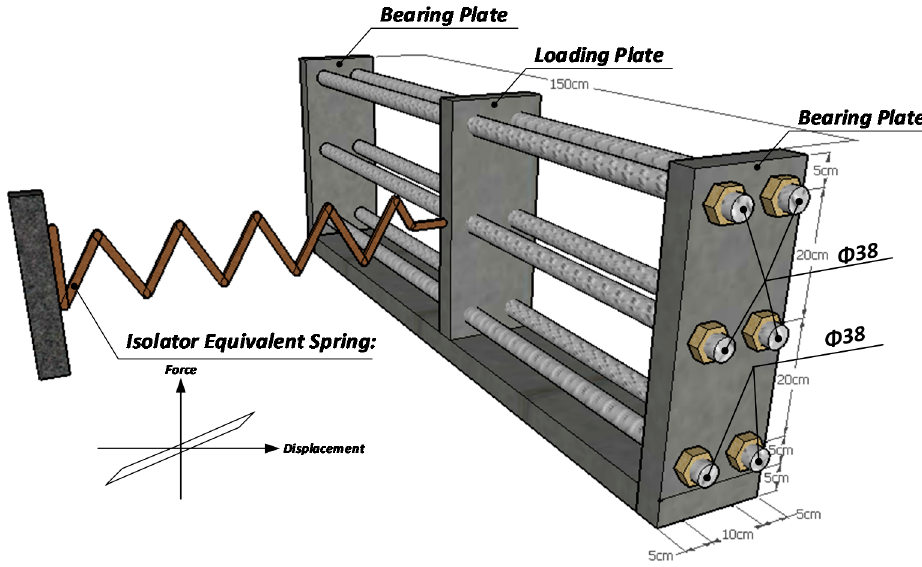
Figure 8. Numerical model of rubber isolator equipped by SBHDs in SeismoStruct software.